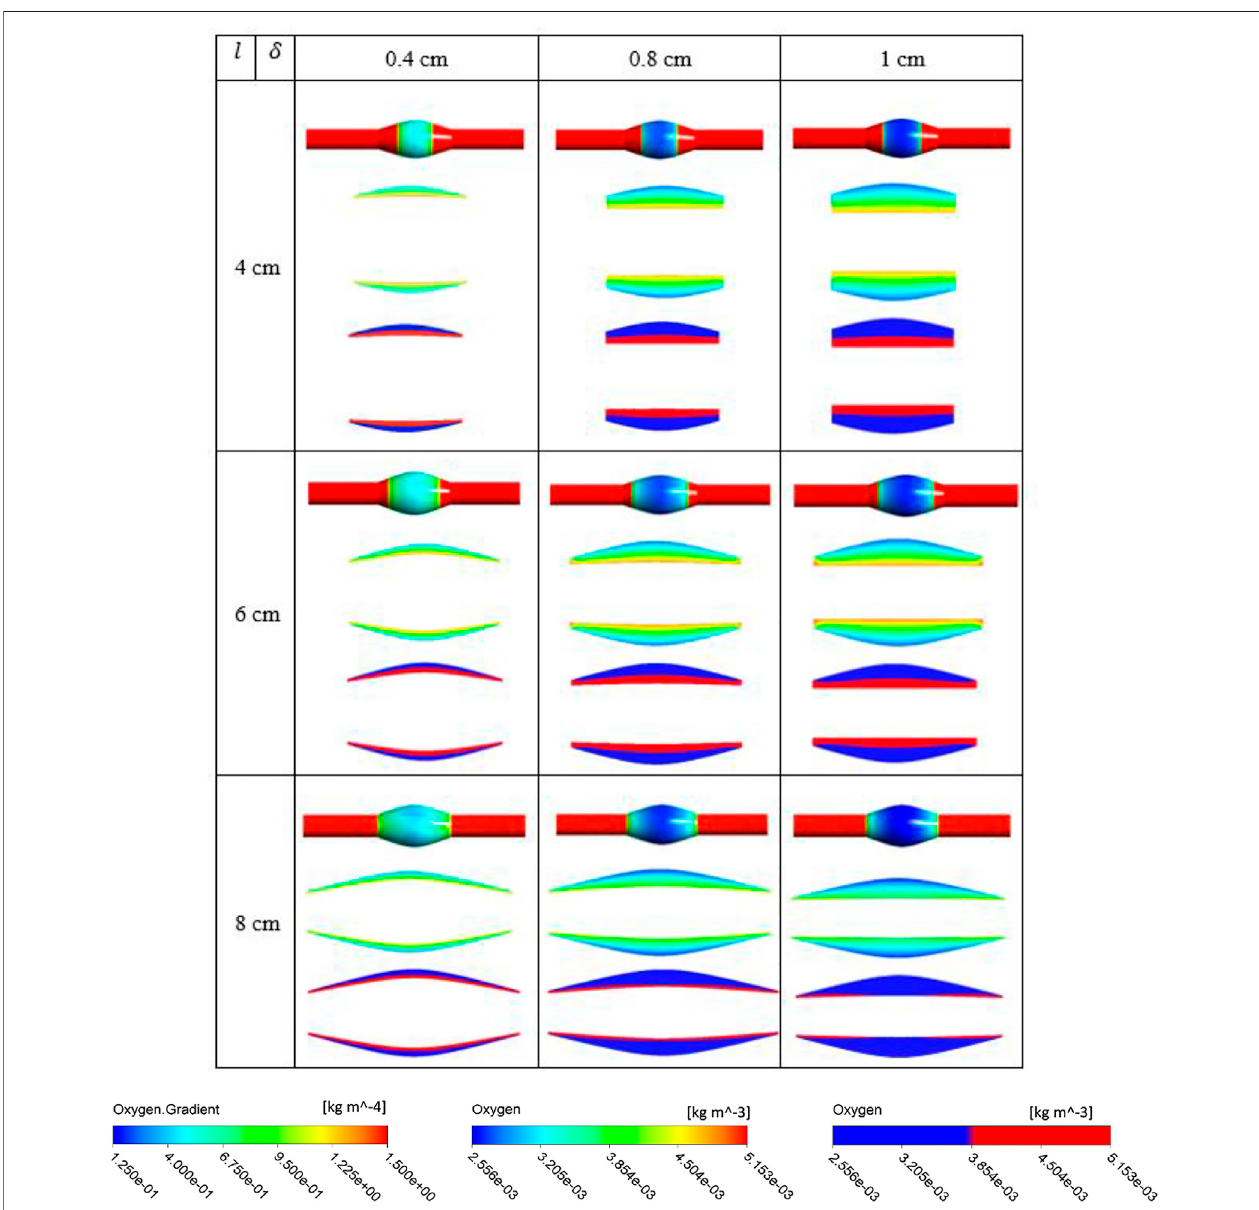
FIGURE 7 | Results of different combination of design variables ILT length ( l ) and ILT thickness ( δ ), with bulge diameter being fi xed as BD = 4.2 cm. Each cell corresponds to the results for one case of the nine different AAA geometries provided in Figure 2 . In each cell, three oxygen measures are plotted from top to bottom: contourofoxygen fl uxontheabluminalsurfaceofthearterialwallforallanalyzedcasesonthesamescale,contourplotofoxygenconcentrationinILTonthesamescale, and fi nally oxygen value using a two-bands color scale ranging from abluminal oxygen concentration 2.56 × 10 − 3 kg/m 3 (blue) to ≥ 75% C in f kg/m 3 (red). Scales on the bottom are used for displaying